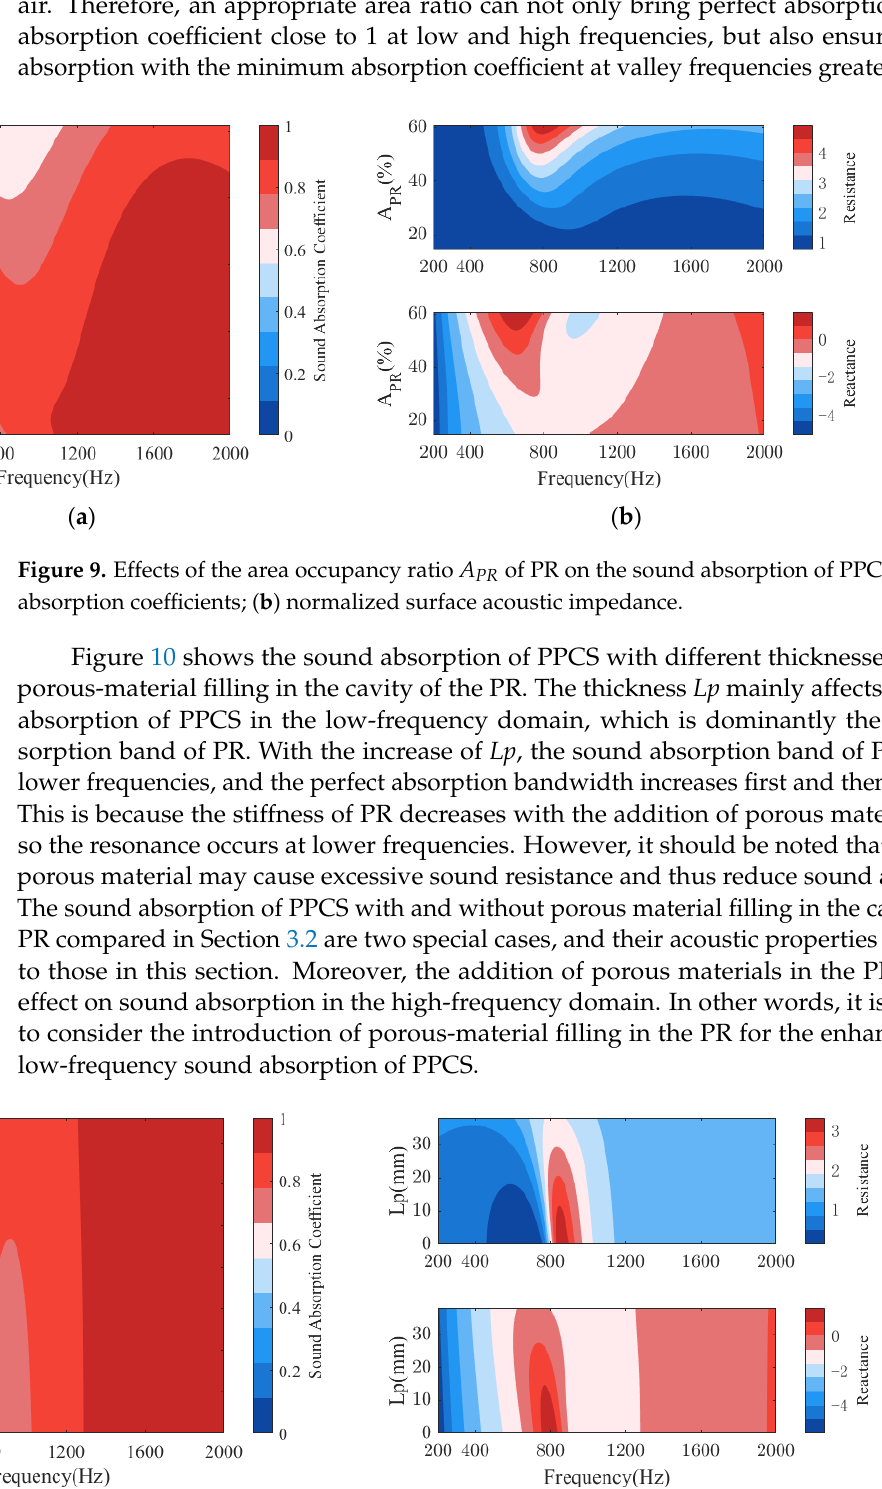
Figure 10. Effects of the porous-material thickness Lp in the cavity of PR on the sound absorption of PPCS: ( a ) sound absorption coefficients; ( b ) normalized surface acoustic impedance. PPCS: ( a ) sound absorption coefficients; ( b ) normalized surface acoustic